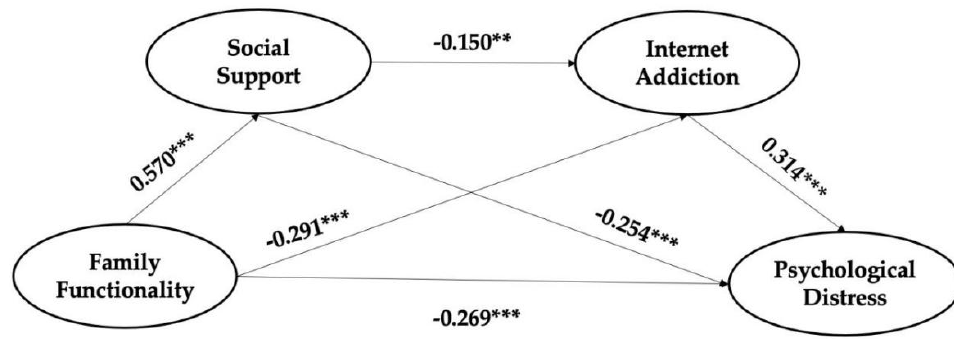
Figure 2. The structural model (** p < 0.01; *** p < 0.001). Table 3. Coefficients of path